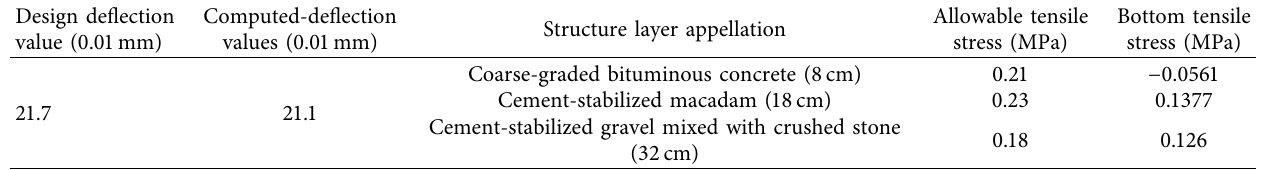
Table 10: Summary of structural calculation and checking results of cement stabilized macadam base asphalt pavement. Design deflection value (0.01mm)